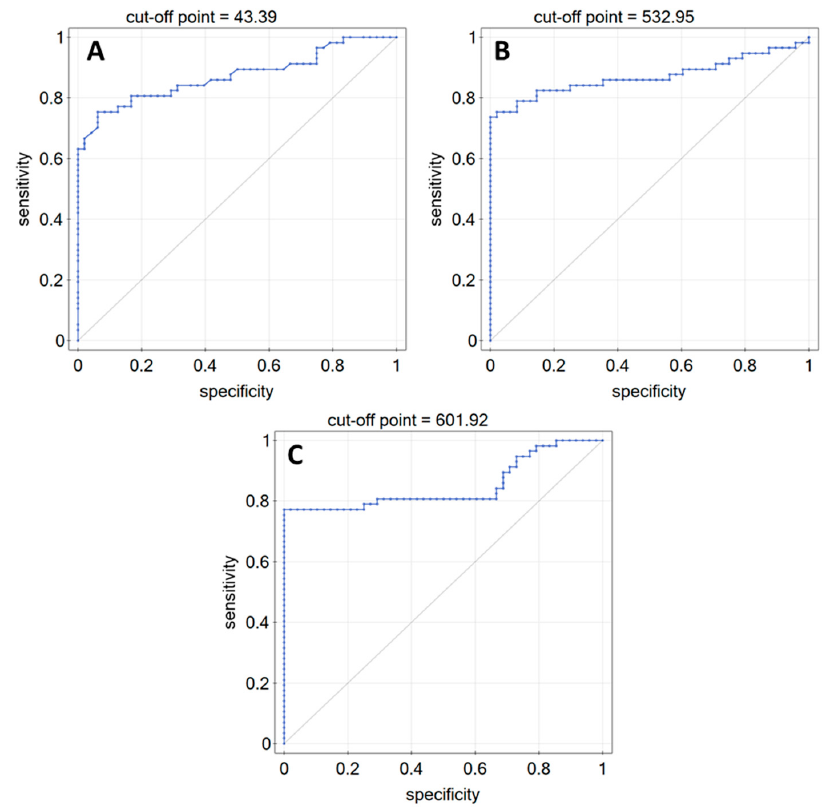
Figure 5. ROC curves: ( A ) LN-5, ( B ) FN, ( C ) COL IV.